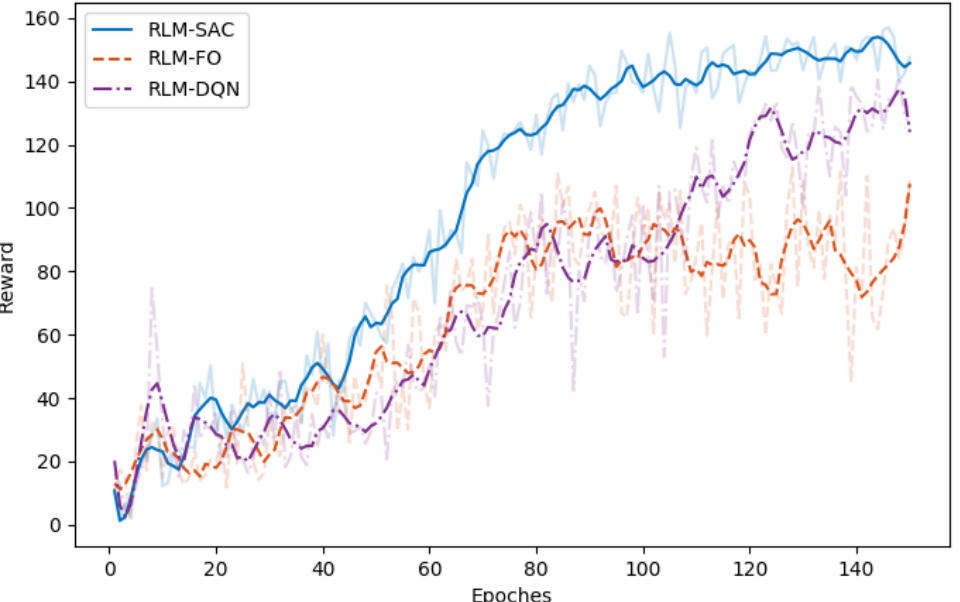
Figure 5. Reward of different RL realizations over the training trajectories. The data are smoothed via Savitzky–Golay filter with window size 15 and order